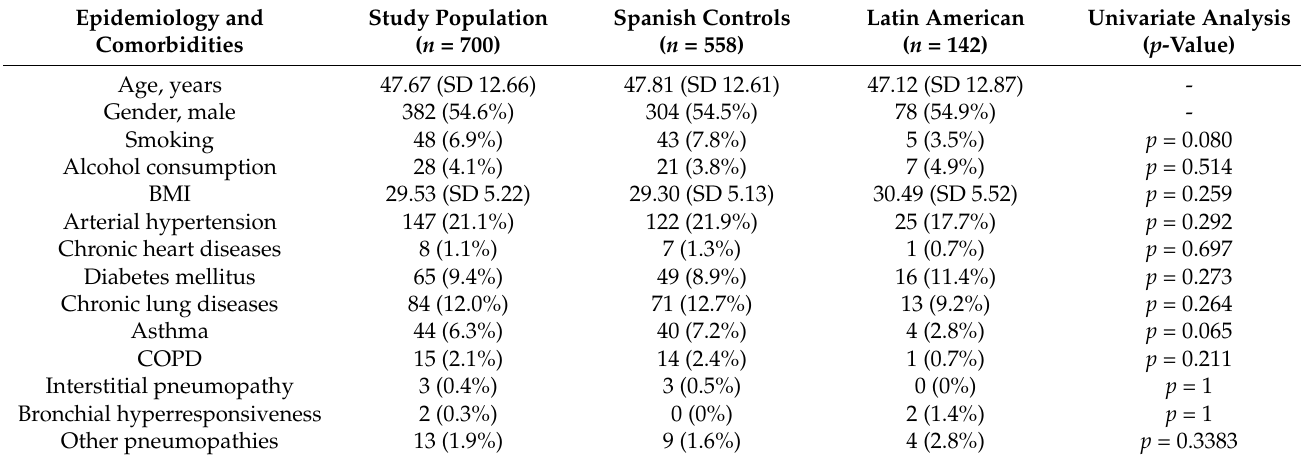
Table 1. Epidemiology and comorbidities in hospitalized patients with COVID-19 pneumonia according to the geographical area of